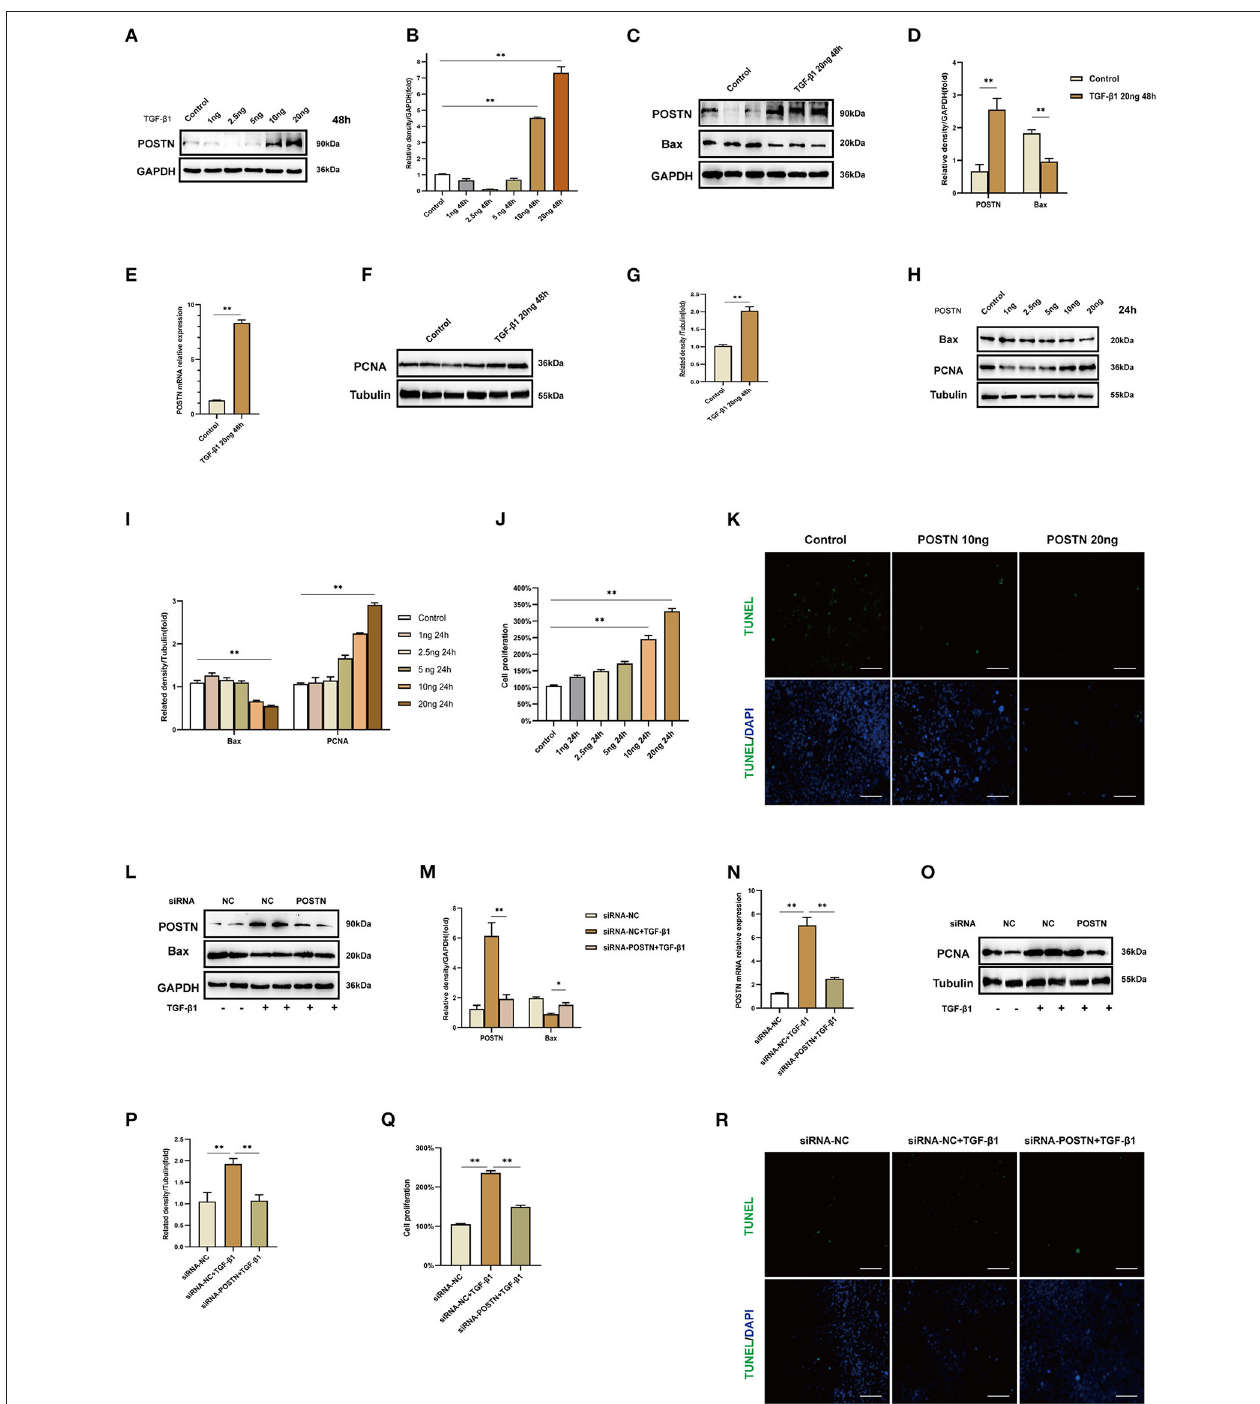
FIGURE 7 | High levels of POSTN enhance the proliferation and suppress apoptosis in MMCs. (A,B) Immunoblot analysis and quantification of POSTN in MMCs treated with indicated concentrations of TGF- β 1 for 48h. (C–I) Immunoblot analysis and quantification of POSTN, BAX, and PCNA in MMCs treated with 20ng/ml TGF- β 1. (H,I) Immunoblot analysis and quantification of BAX and PCNA in MMCs treated with indicated concentrations of recombinant POSTN protein for 24h. (J) Proliferation of MMCs as detected with the CCK-8 assay. (K) Detection of apoptotic cells with the TUNEL assay. Scale bar: 50 µ m. (L,M) siRNA-mediated POSTN knockdown in MMCs. Immunoblot analysis and quantification of POSTN and BAX levels in TGF- β 1–treated MMCs after POSTN knockdown. (N) POSTN mRNA level in TGF- β 1–treated MMCs after POSTN knockdown. (O,P) Immunoblot analysis and quantification of PCNA in TGF- β 1–treated MMCs after POSTN knockdown. (Q,R) Detection of proliferation and apoptosis with the CCK-8 and TUNEL assays, respectively, in TGF- β 1–treated MMCs after POSTN knockdown. Scale bar: 50 µ m. Data are presented as mean ± SEM ( n = 3). * P < 0.05, ** P < 0.01.